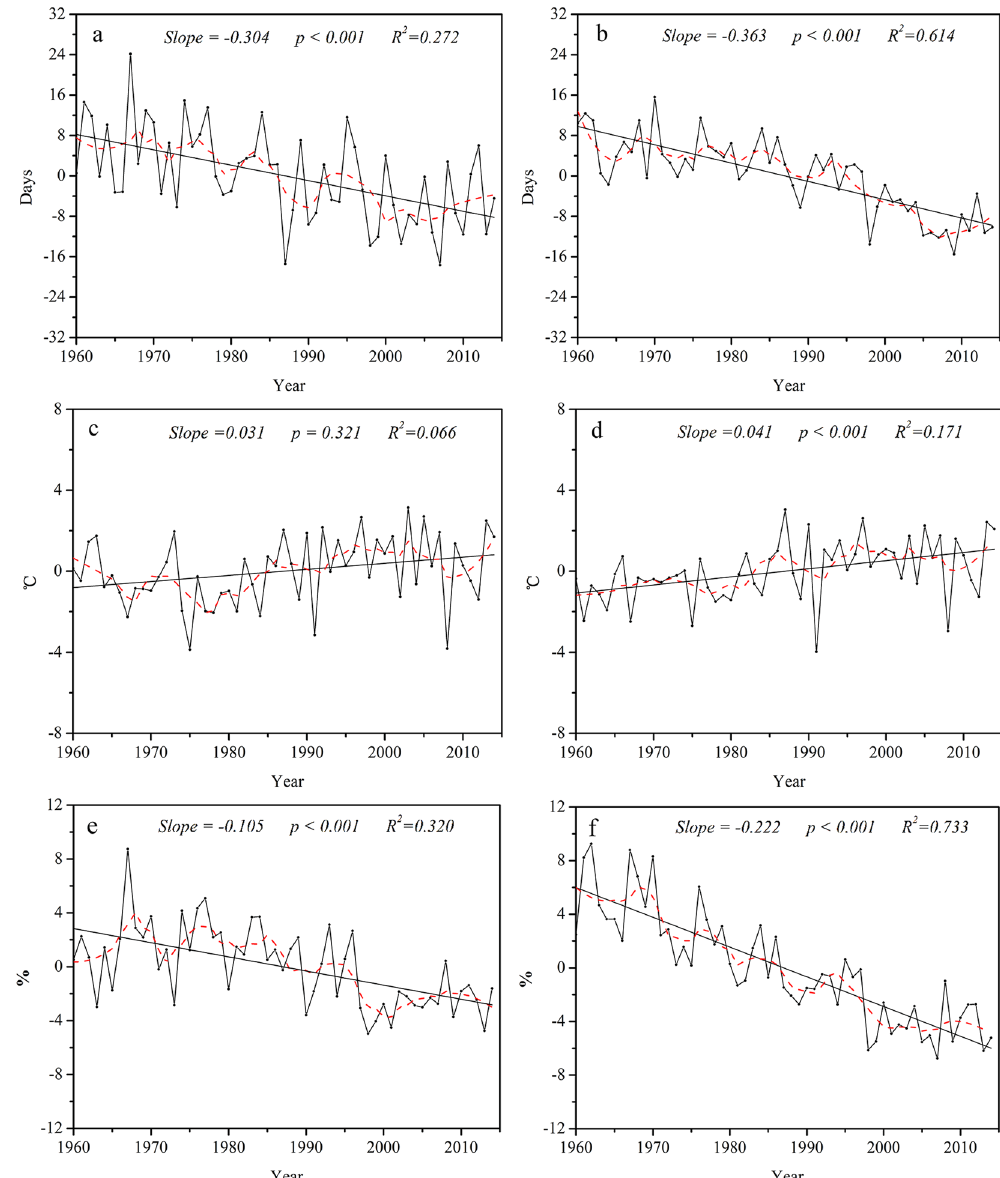
Figure 5. Annual regional averaged series for cold extremes. Cold indices: ice days ( a ), frost days ( b ), coldest day ( c ), coldest night ( d ), cool days ( e ), cool nights ( f ). For description of indices, see Supplementary Table S1. Straight line represents linear regression and the dash line is the 10-year smoothed